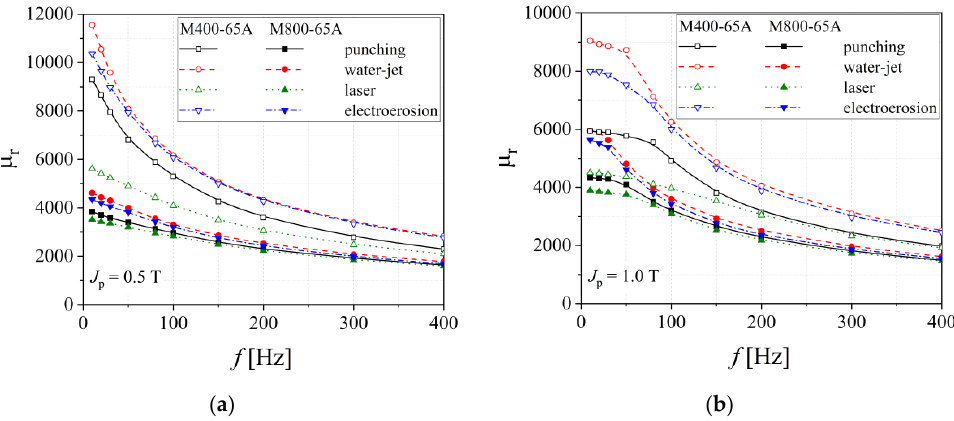
Figure 6. Total energy loss versus frequency measured at J p = 1.0 T of two electrical steel types ( a ) M800 and ( b ) M400, in the case of different sample thickness (0.50 mm and 0.65 mm).